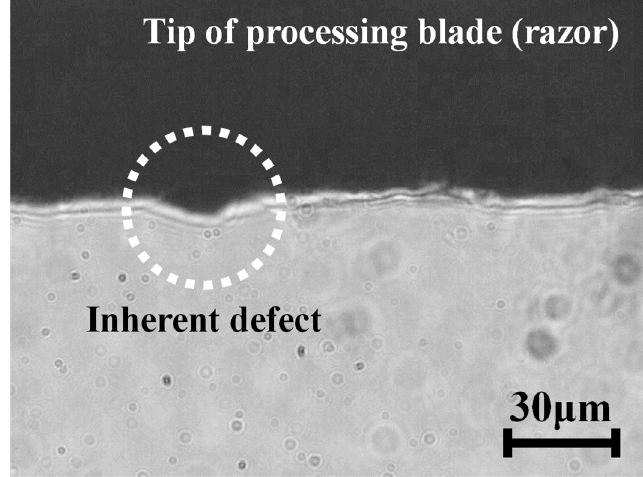
Figure 9. Inherent defect at the tip of the processing blade.